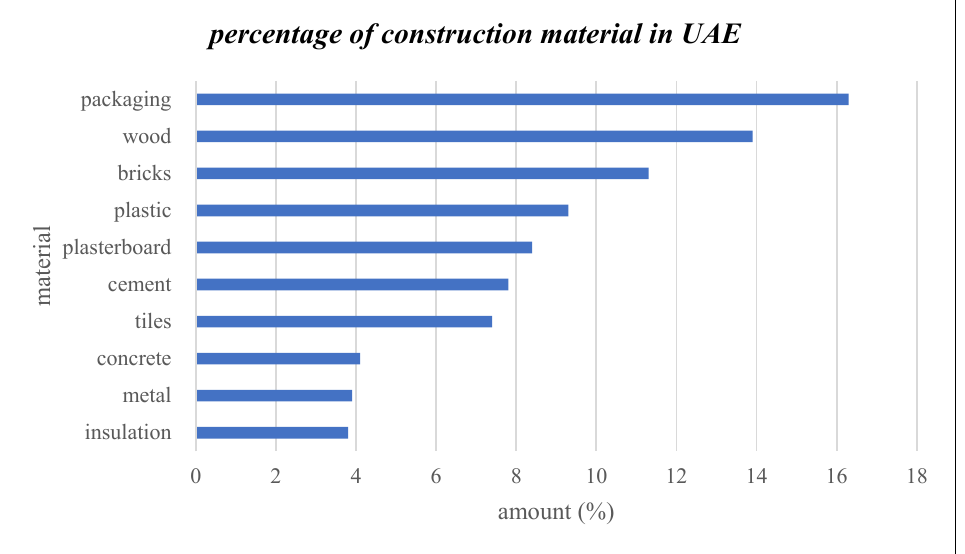
Figure 2. Percentage of construction materials used in the UAE.